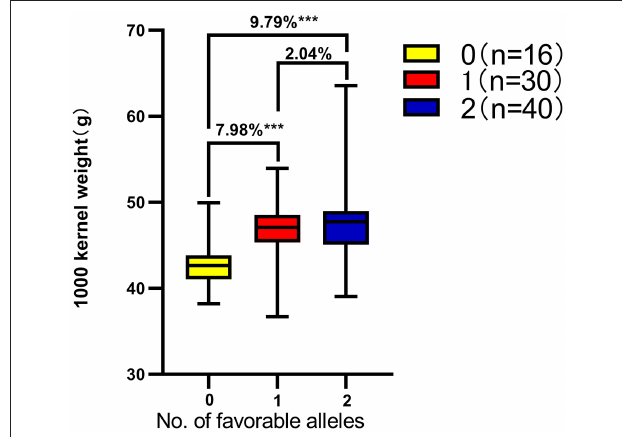
FIGURE 6 | Number of favorable alleles for two kernel-related QTLs on thousand grain weight in the Chuannong18/T1208 RIL population based on the across-environment BLUEs. ***Significant at P < 0.001. Genotype of 40 lines were AAbb , 30 lines were AABB or aabb , and 16 lines were aaBB . The TKW of the AAbb , AABB , and aabb genotype lines was significantly higher than that of the aaBB genotype lines.